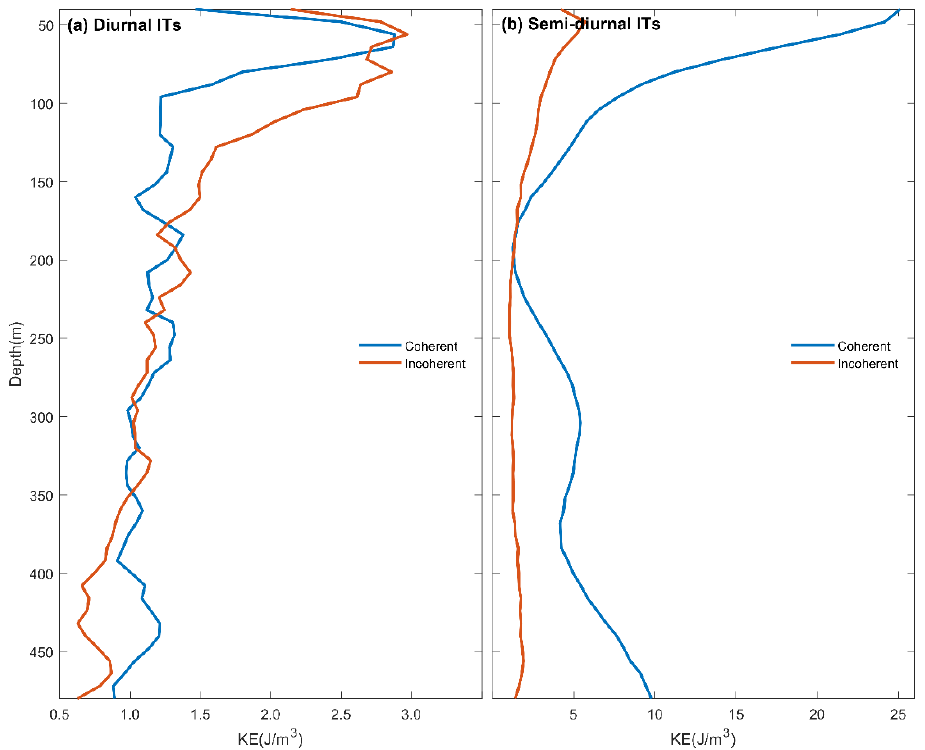
Figure 5. Temporal mean coherent and incoherent kinetic energy density of ( a ) diurnal and ( b ) semidiurnal internal tides.